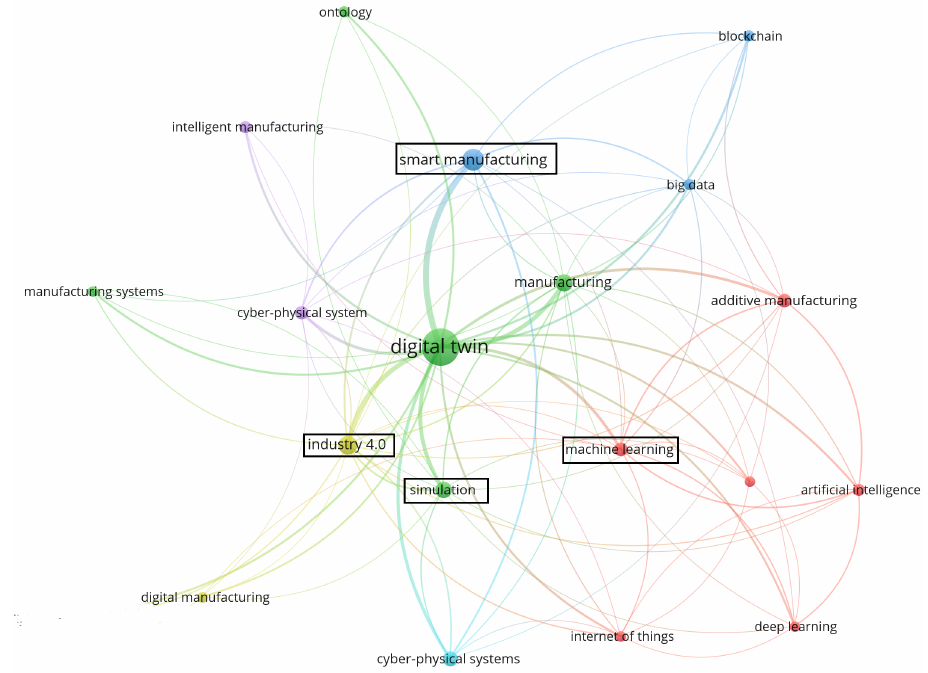
Figure 1. DT in manufacturing. Network graph of keywords. Each keyword is represented with a circle and connections between keywords with connecting